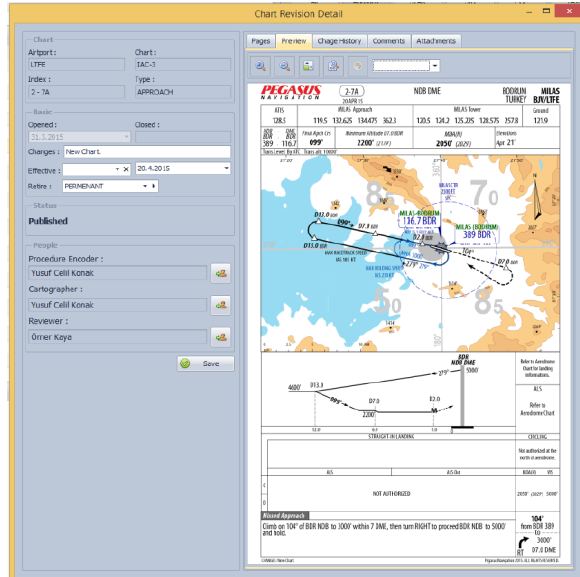
Figure 8. A screenshot from the work flow management